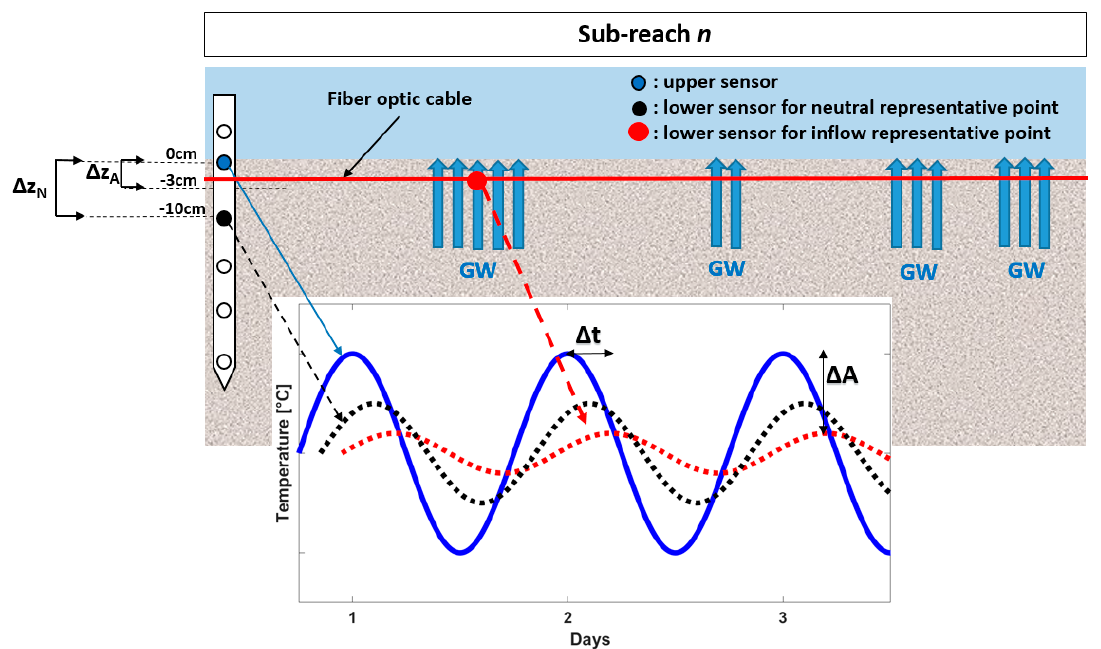
Figure 2. Conceptual representation of calculating vertical flow along a sub-reach. The upper sensor used for all velocity calculations is the thermal sensor at the water–sediment interface (z = 0 cm). A clear and perennial groundwater (GW) inflow is selected as a representative point and the fiber optic distributed temperature sensing (FO-DTS) point set above it is used as the lower sensor for calculating inflow velocity (z = − 3 cm). A clear and perennial atmosphere-influenced stream water location was selected in each sub-reach as representative of “neutral” sections. In this study, all thermal lances were set in neutral locations without inflow: their stability in the sediment made them more accurate than the FO-DTS system in calculating the representative neutral flows (z = − 10 cm).